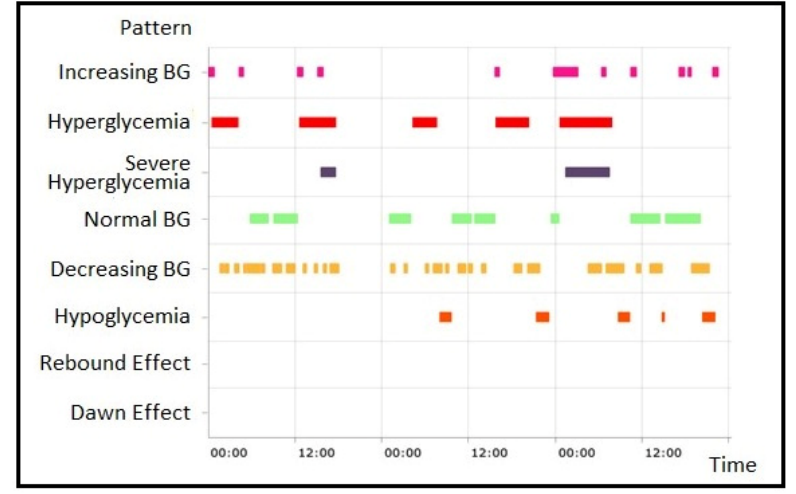
Figure 10. Pattern visualization for the single patient.